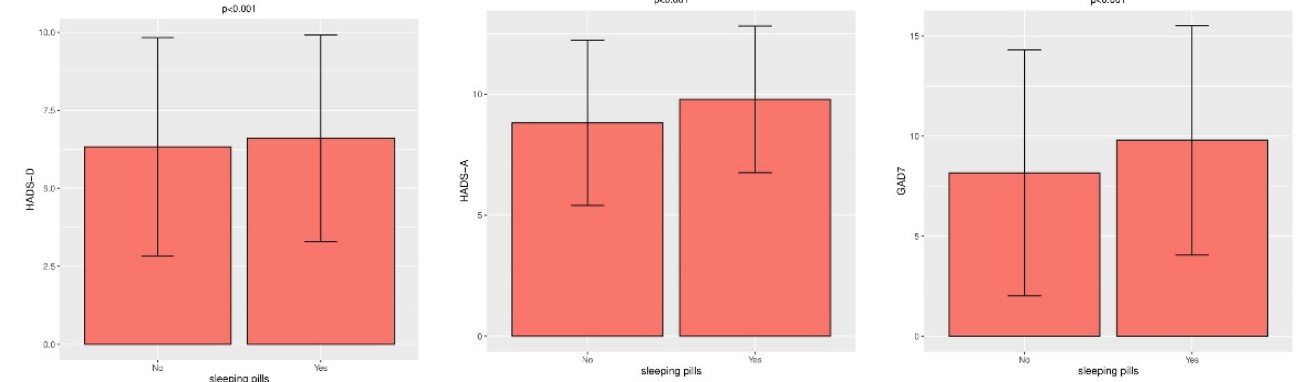
Figure 2. Relationship between the indications of the HADS and GAD-7 scales and the use of sleep